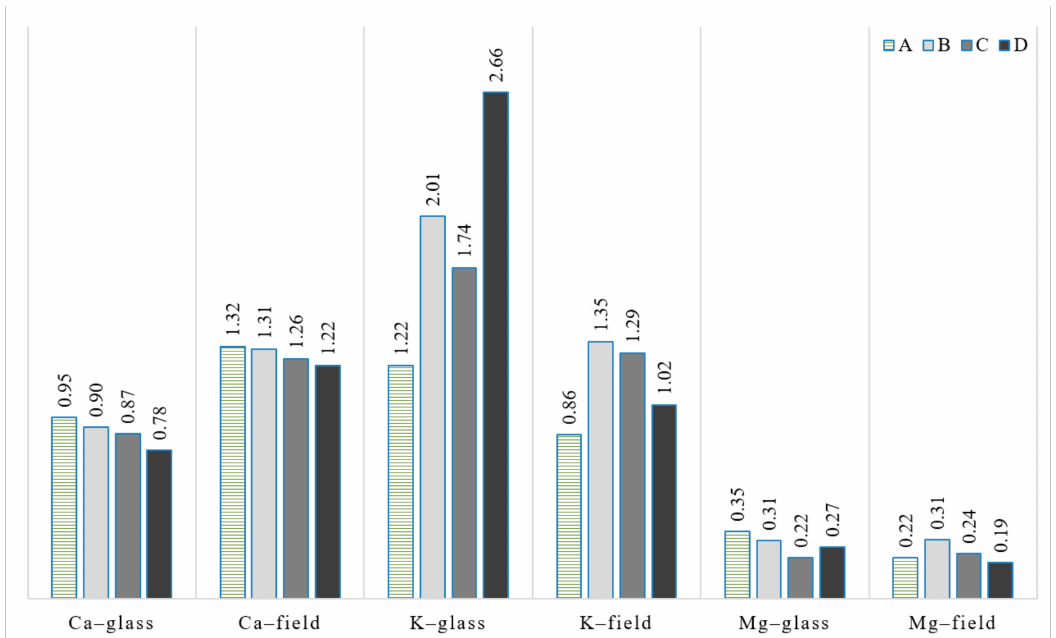
Figure 6. Average content of Ca, K and Mg in the test plants cultivated in the greenhouse and in the field (in %